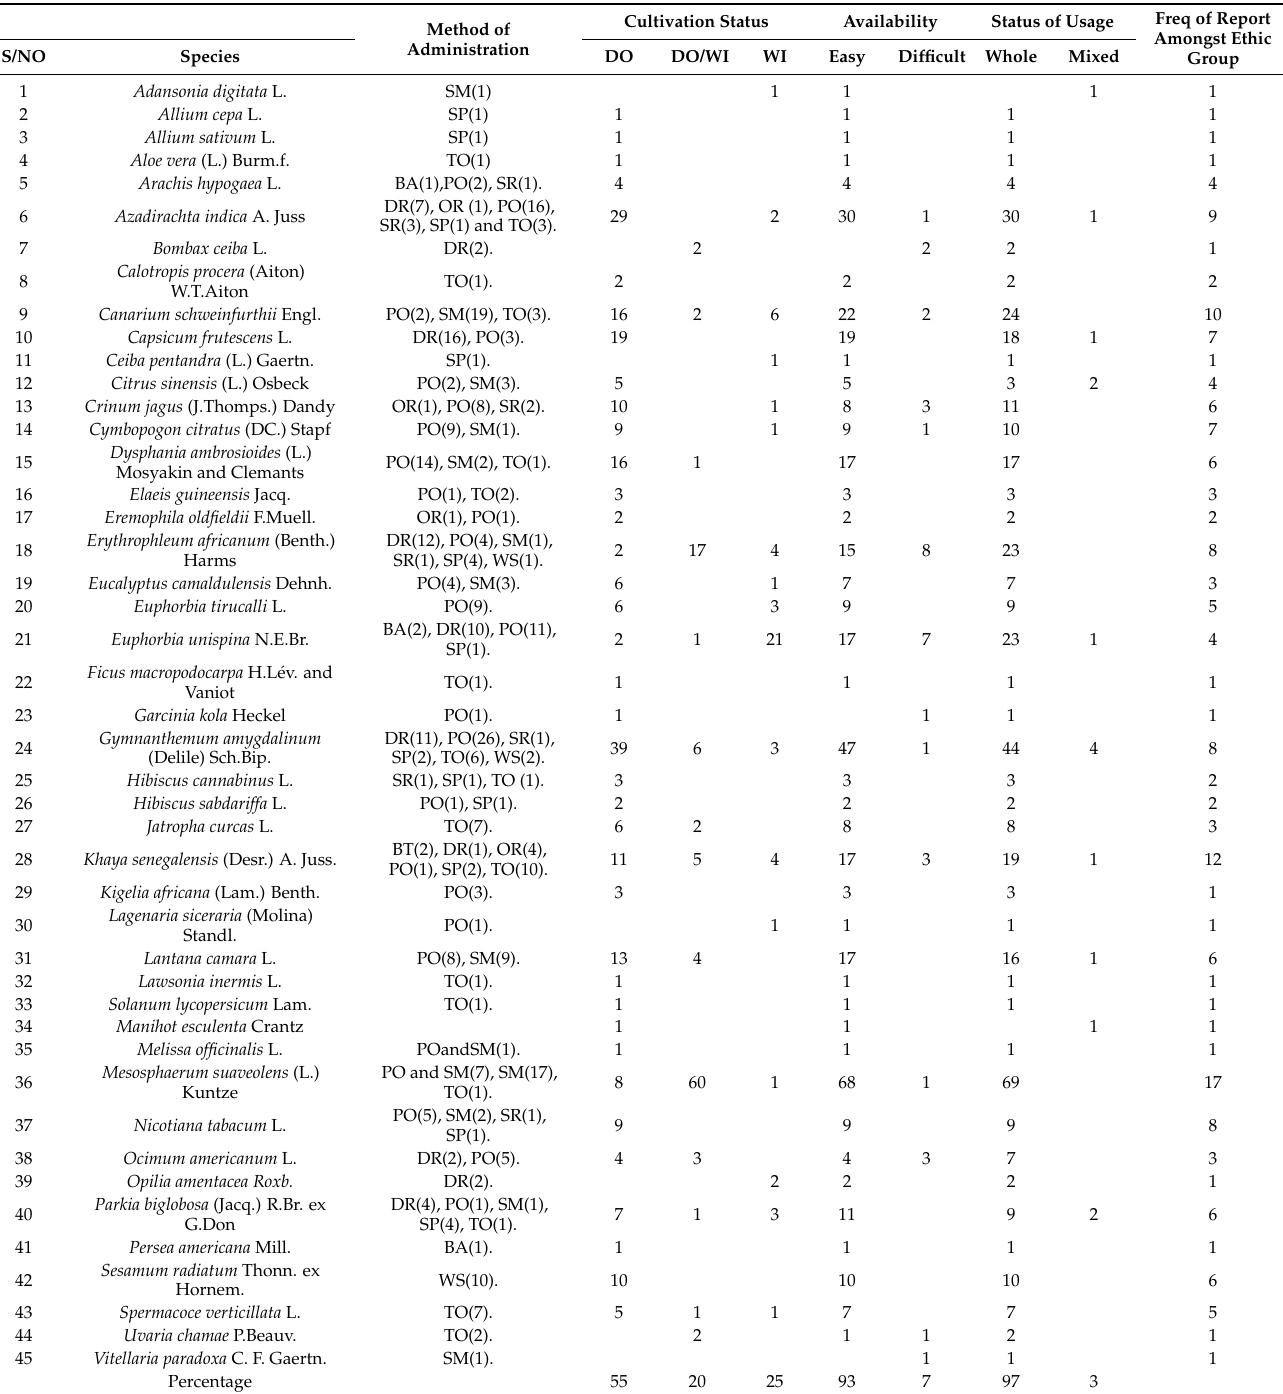
Table 3. Method of Administration, Cultivation Status, Availability, and Status of Usage of Pesticidal Ethnobotanical Plants in Plateau